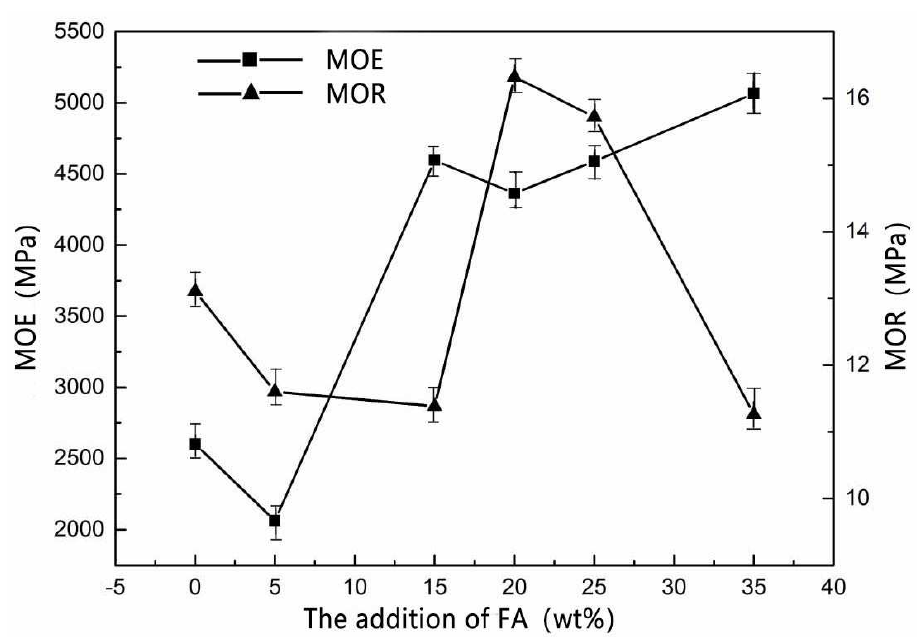
Figure 2. Mechanical strength of MOPB - FA (H = 10, M = 5).